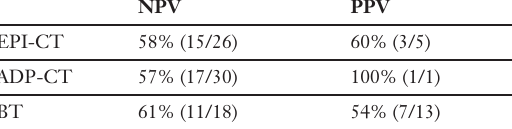
Negative predictive value (NPV) and positive predictive value (PPV) of the PFA-100 ® and the bleeding time (BT) to detect von Willebrand disease or mild platelet disorder.